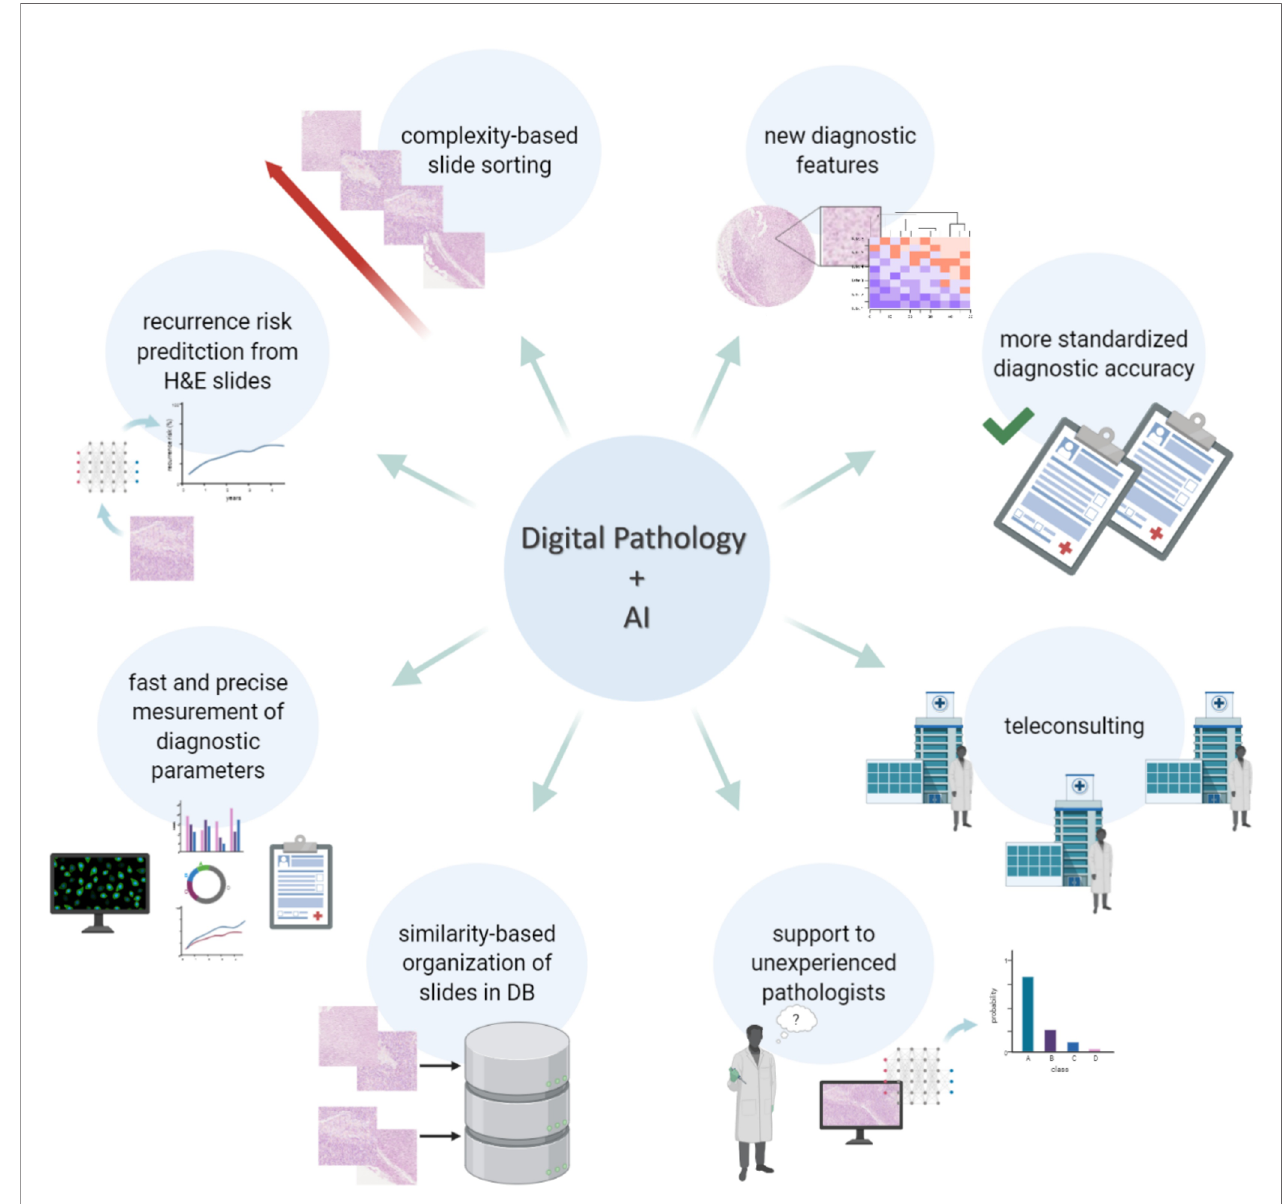
FIGURE 2 | Searching for predictive biomarkers in malignant melanoma with spatial multiplexing techniques: advantages and challenges. Predictive evaluation of malignant melanoma is needed for a more personalized treatment plan, but predictive biomarkers must still be identi fi ed. Conventional IHC is a single-plex based method which does not provide information at single-cell level. On the other hand, multiplexed IHC and spatial -omics methods make it possible to extract information from multiple markers at single-cell resolution and to investigate cell-cell interactions. However, despite the great advantages, those techniques have not yet been validated in clinics and it is currently not possible to integrate the information from different -omics on the same section at single-cell level. Moreover, those methods are strictly dependent on computational techniques for the downstream analysis, hence they carry all the challenges related to image